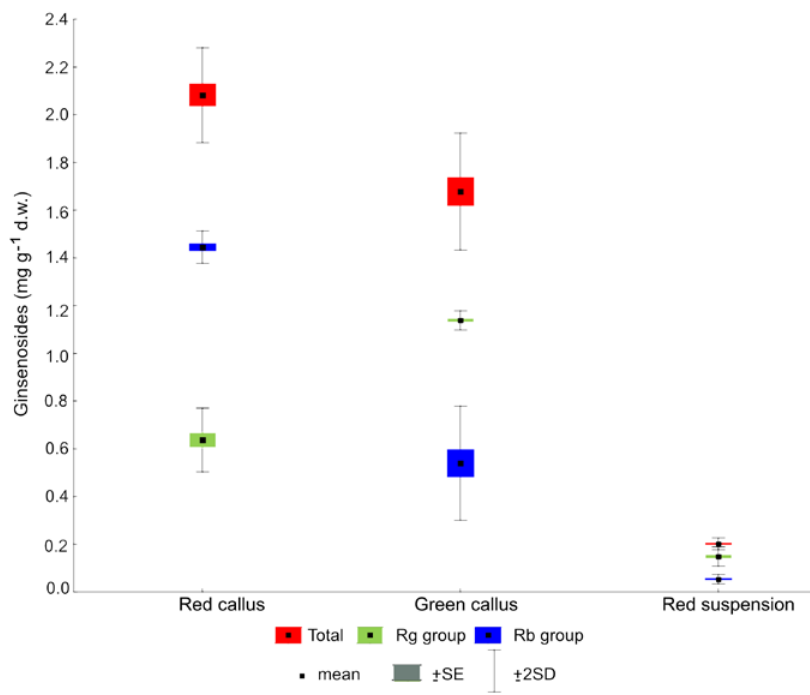
Fig. 3 The content of protopanaxadiol (expressed as the sum of Rb1, Rb2, Rb3, Rc, and Rd) and protopanaxatriol (expressed as the sum of Rg1 and Re) derivatives, as well as total ginsenosides (sum all of the determined saponins) in cell cultures of Panax quinquefolium . Each value represents the mean of three replicates ± SE